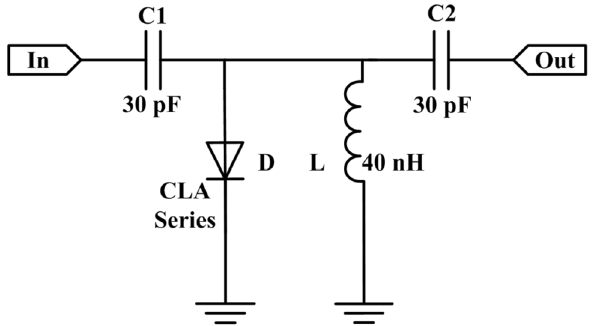
Figure 1. Structure of the single-stage PIN diode limiter used in the study.